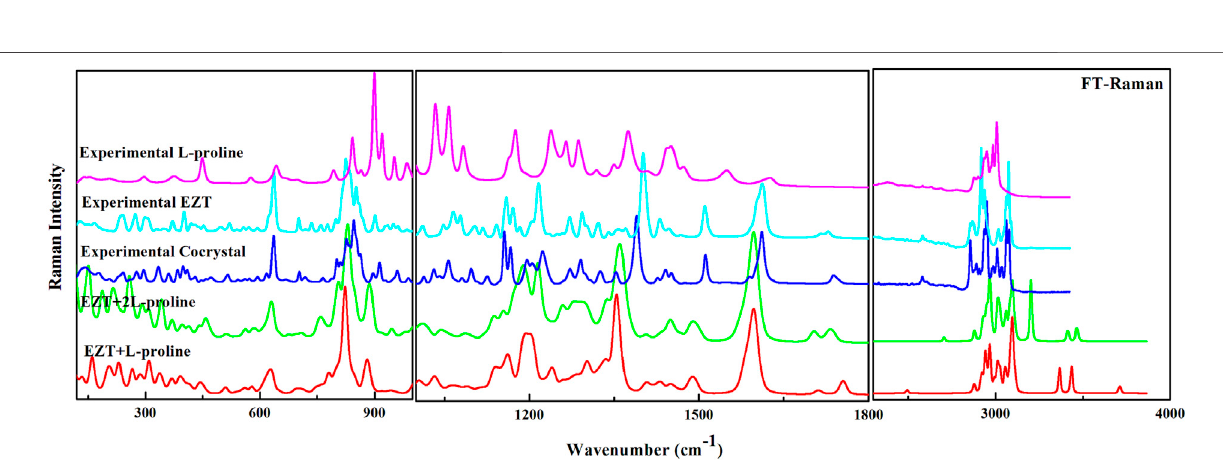
Frontiers in Chemistry |